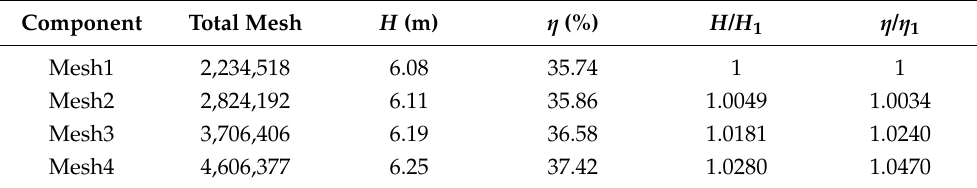
Table 1. Grid independence verification.